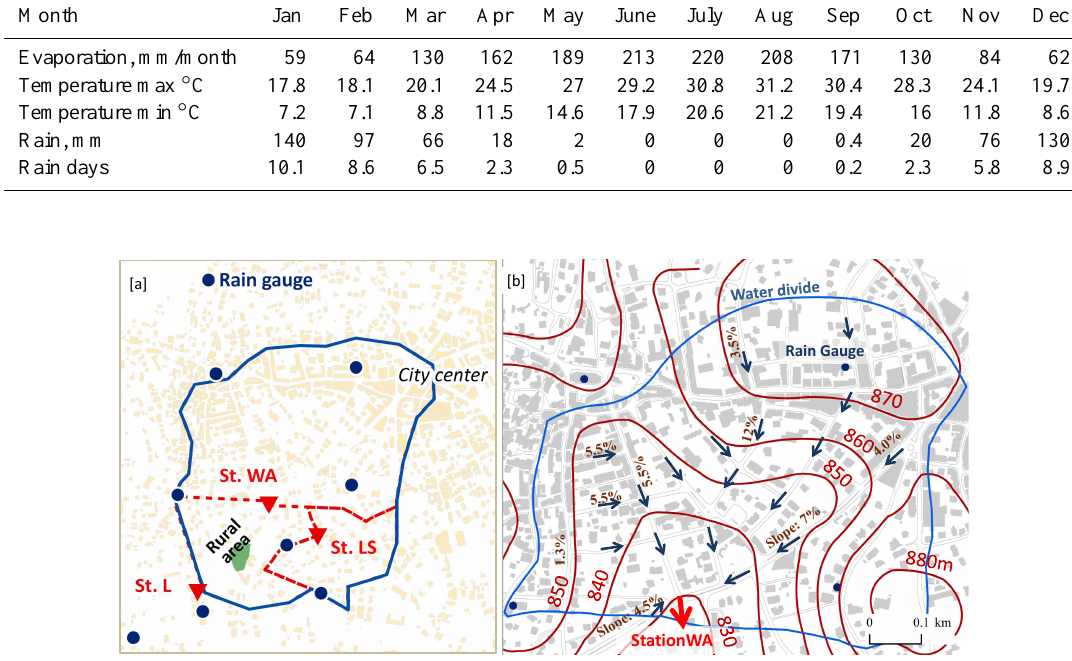
Fig. 2. (a) Ramallah city core and the investigated basins; (b) zoom into the sub basin and the hydrometric station WA. Road slopes (%) and urban runoff flow-lines are indicated (blue arrows). Roads following the pre-urbanization